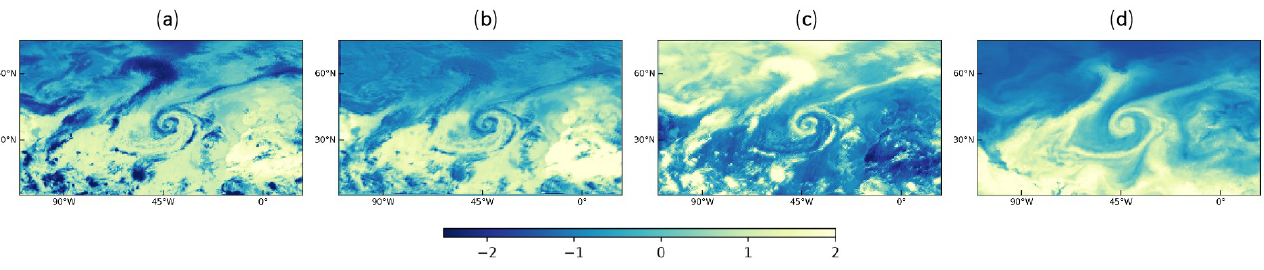
Figure 10. Example of new input data using the autoencoder and the water vapor column. ( a ) Original image (wavenumber at 969.75 cm − 1 ) ( b ) Latent space channel 1. ( c ) Latent space channel 2. ( d ) Water vapor column. Due to the normalization, the colorbar unit is